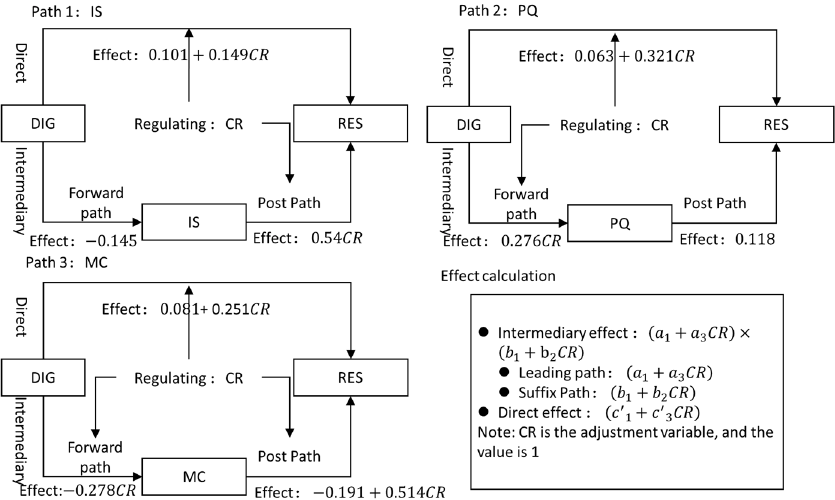
Figure 2. The role of digital economy and carbon emissions on urban economic resilience.